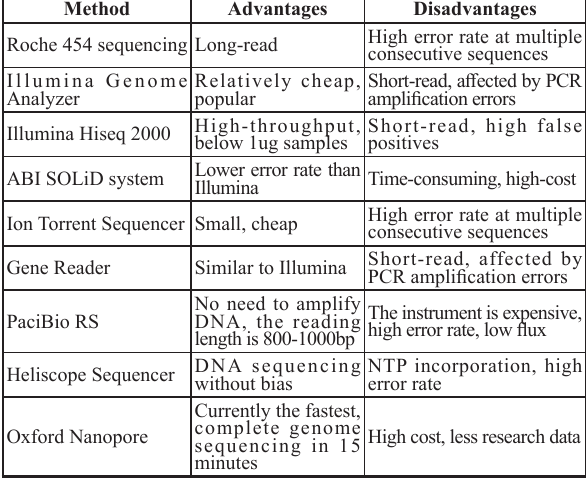
(23). The gold standard refers to the more reliable methodologies, however it does not indicate in any waythat the result of each gold standard is more reliable than the next-generation Table 1. Next generation sequencing platform and its characteristics.